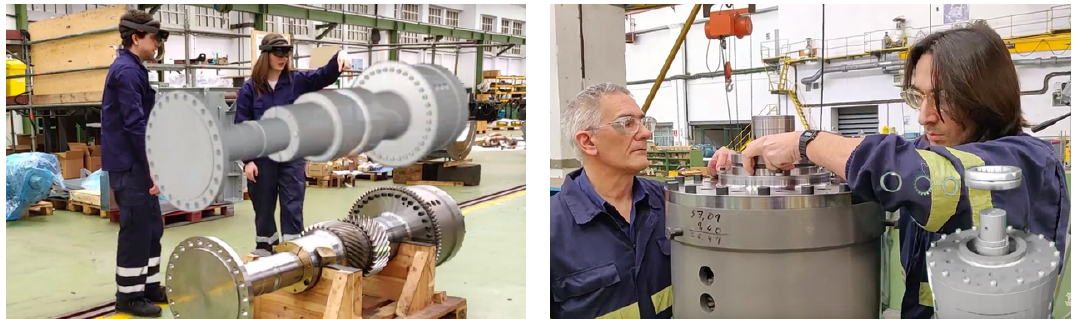
Figure 1. Interaction with the 3D model ( left ) and assembly process at Navantia’s Turbine workshop ( right